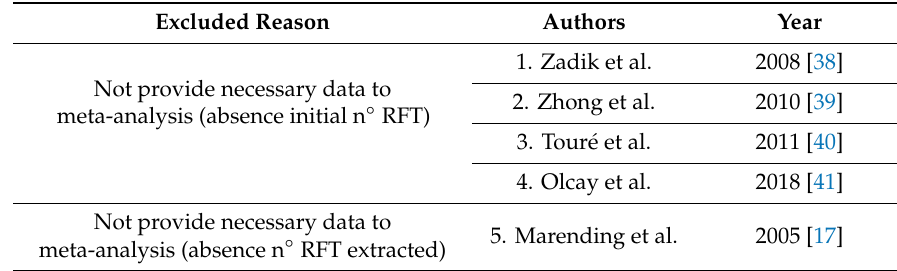
Table 1. Studies excluded in the systematic review of association between smoking habits and the prevalence of root-filled teeth extraction. Excluded reason, authors, and year of these